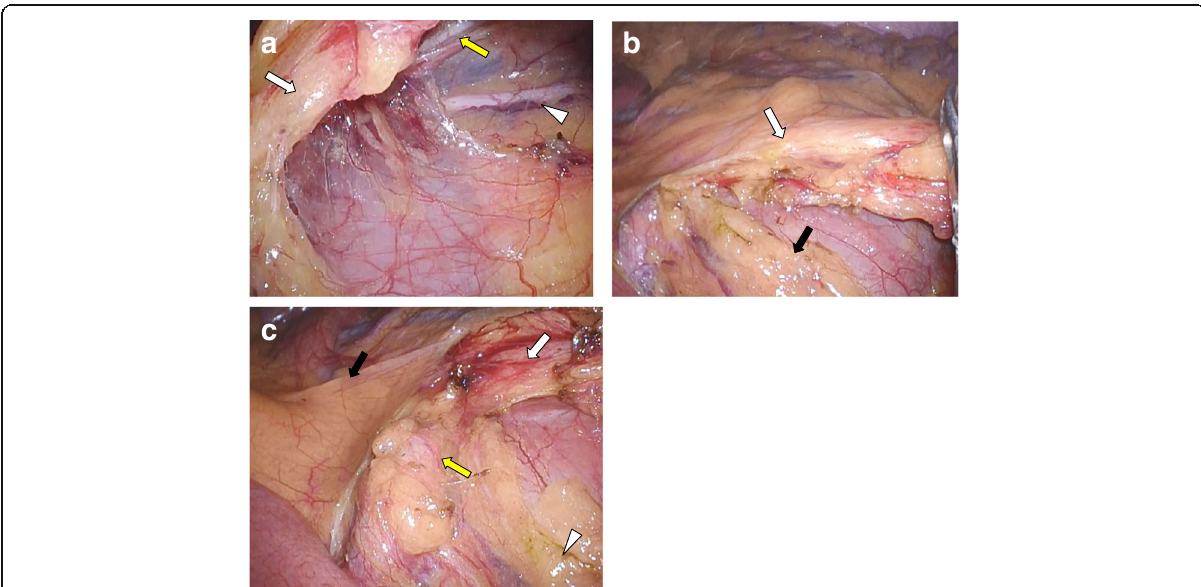
Fig. 2 Surgical findings. a , b The IMA (white arrow), left ureter (arrowhead), left gonadal vessels (yellow arrow), and hypogastric nerve plexus (black arrow) could be seen passing over the horseshoe kidney isthmus and preserved. c The root of IMA (black arrow) was located considerably cephalad to the renal isthmus (arrowhead), and the left branch of aberrant renal artery (yellow arrow) was close to IMA (yellow arrow)